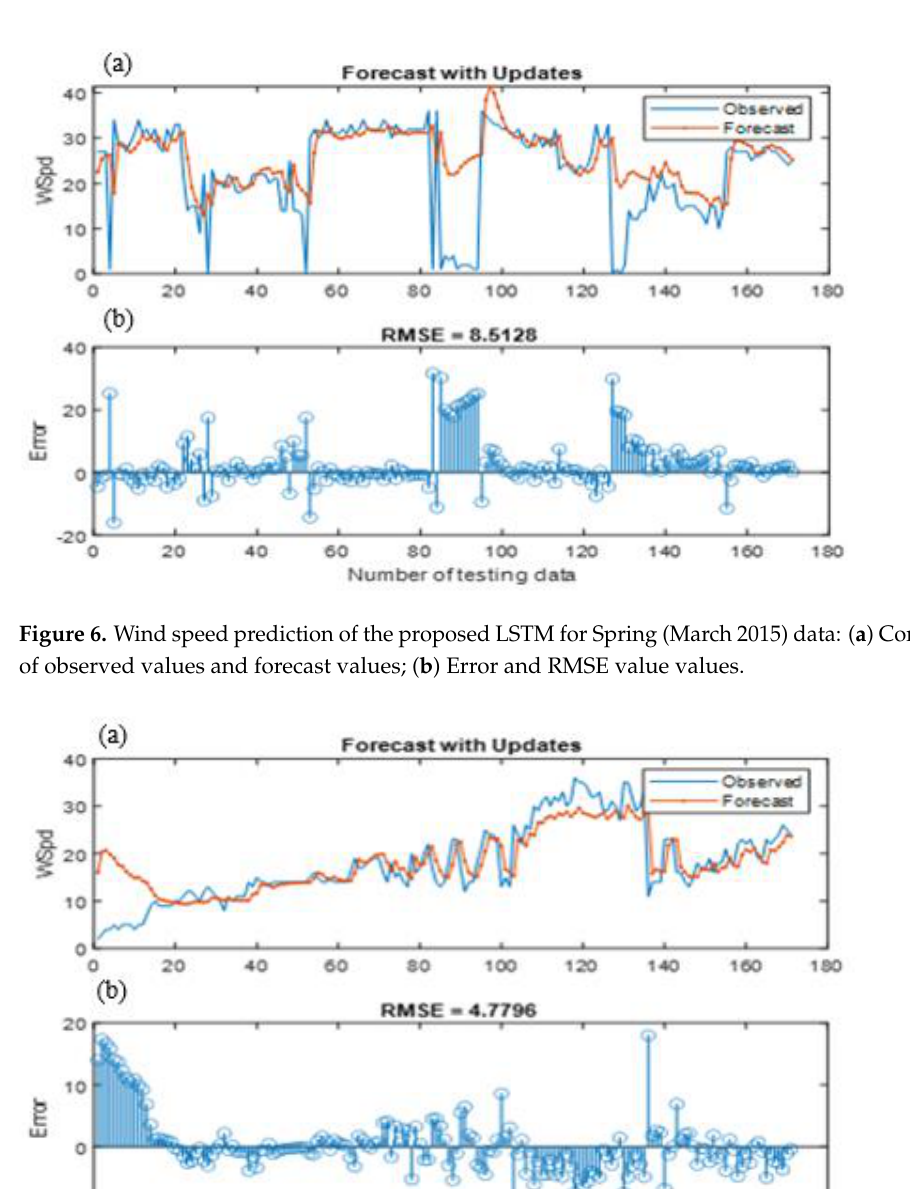
Figure 5. Wind speed prediction of existing LSTM for Summer (July 2015) data: ( a ) Comparison of observed values and forecast values; ( b ) Error and RMSE value values.